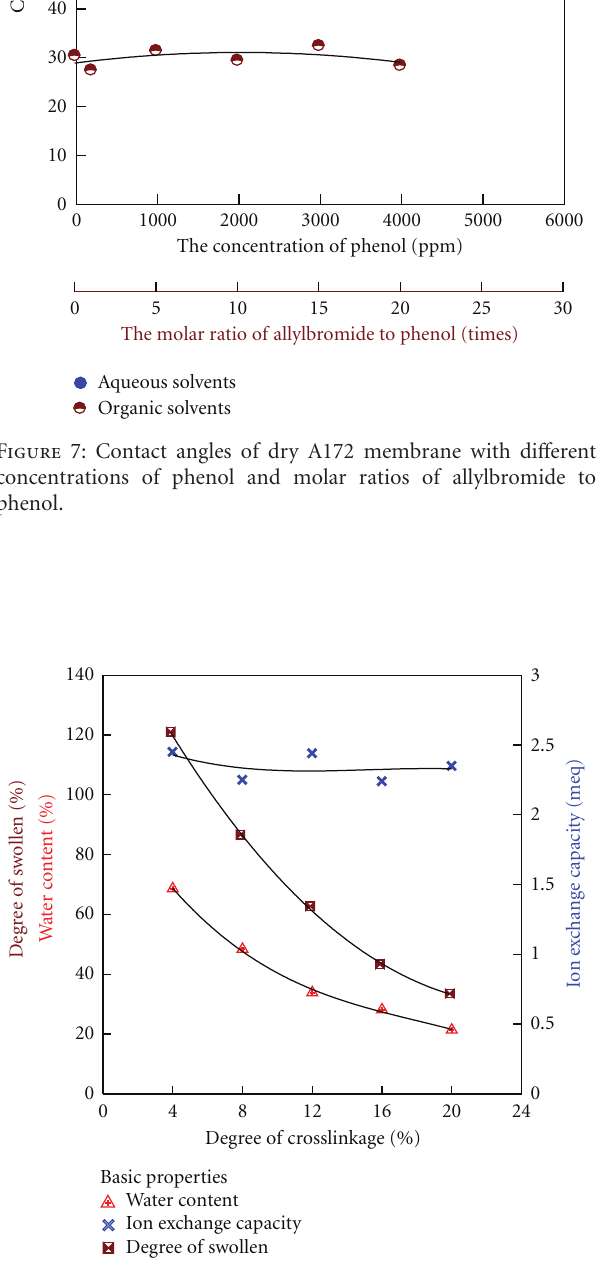
Figure 8: E ff ects of degree of crosslinkage on swelling, water con- tent, and ion exchange capacity of a tetra-methylamine membrane.